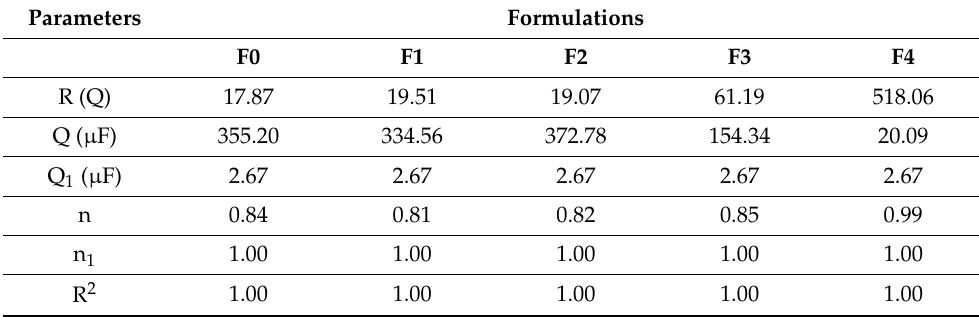
Table 4. RQ(Q) parameters of the impedance obtained through the model fitting.